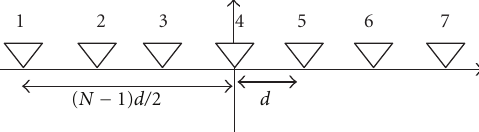
Figure 14: Symmetric ULA with 7